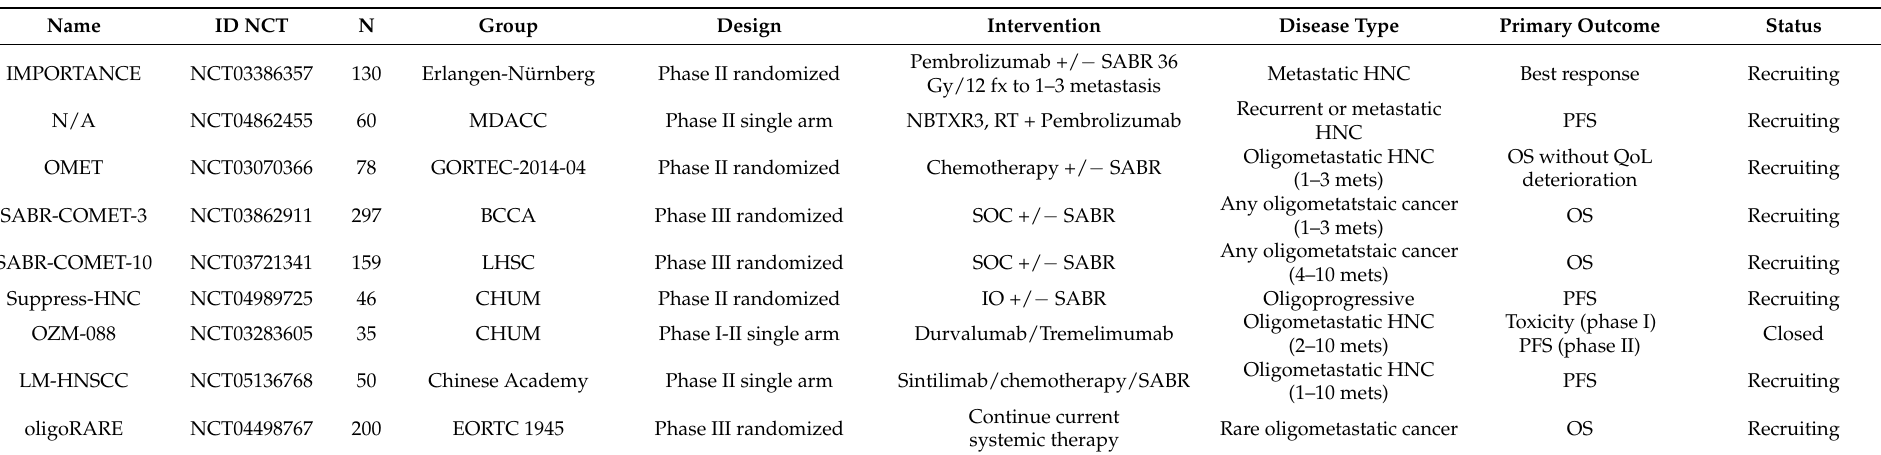
Table 1. Ongoing studies of combined SABR and systemic treatment in metastatic